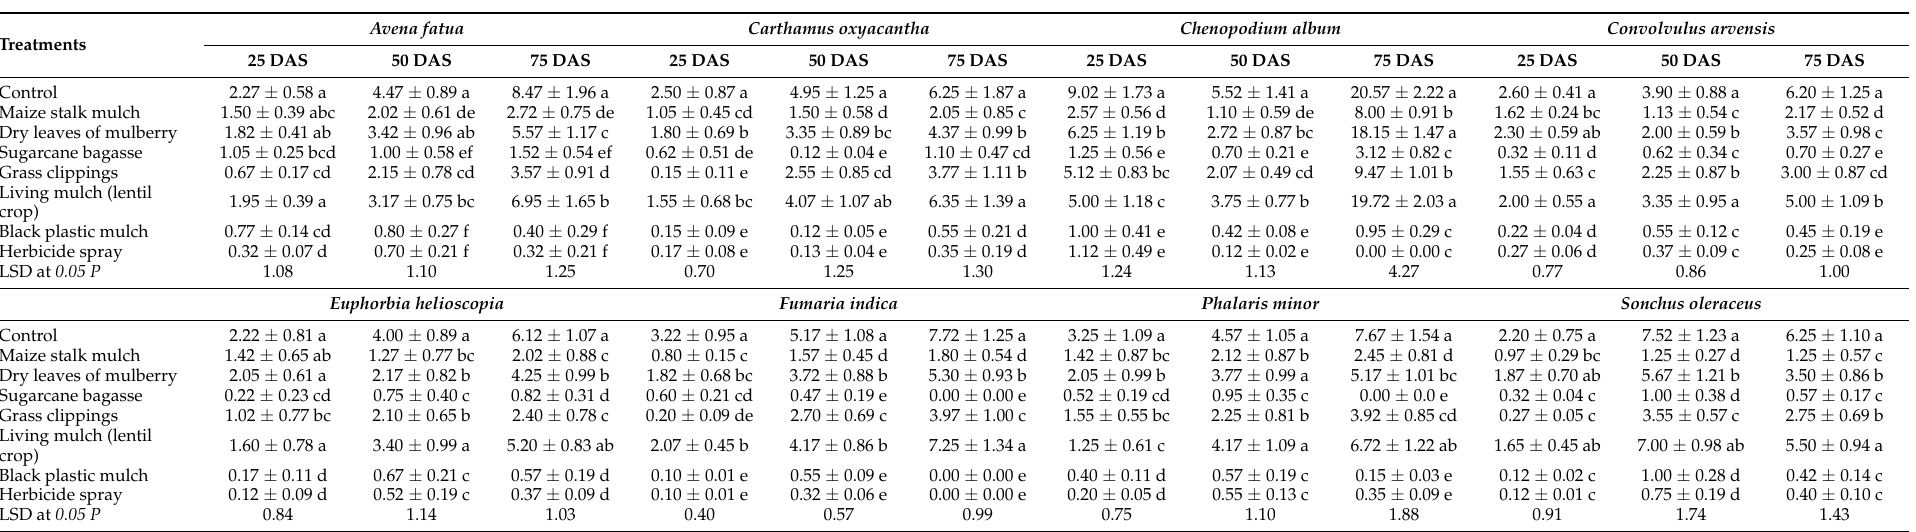
Table 4. Effect of various mulch materials on dry biomass (g) of different weed species of